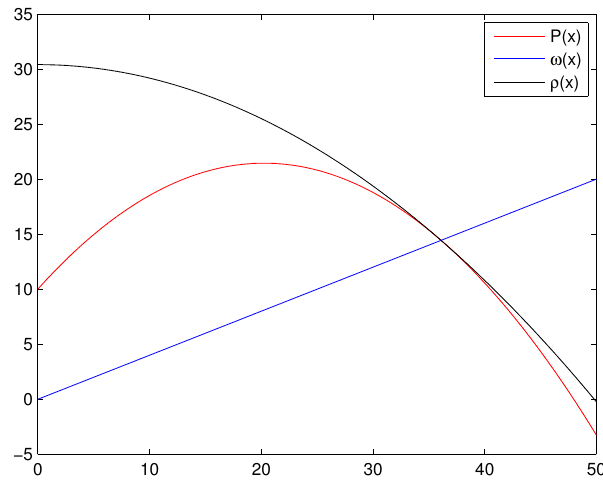
Figure 1. The enveloping parabola with linear impact